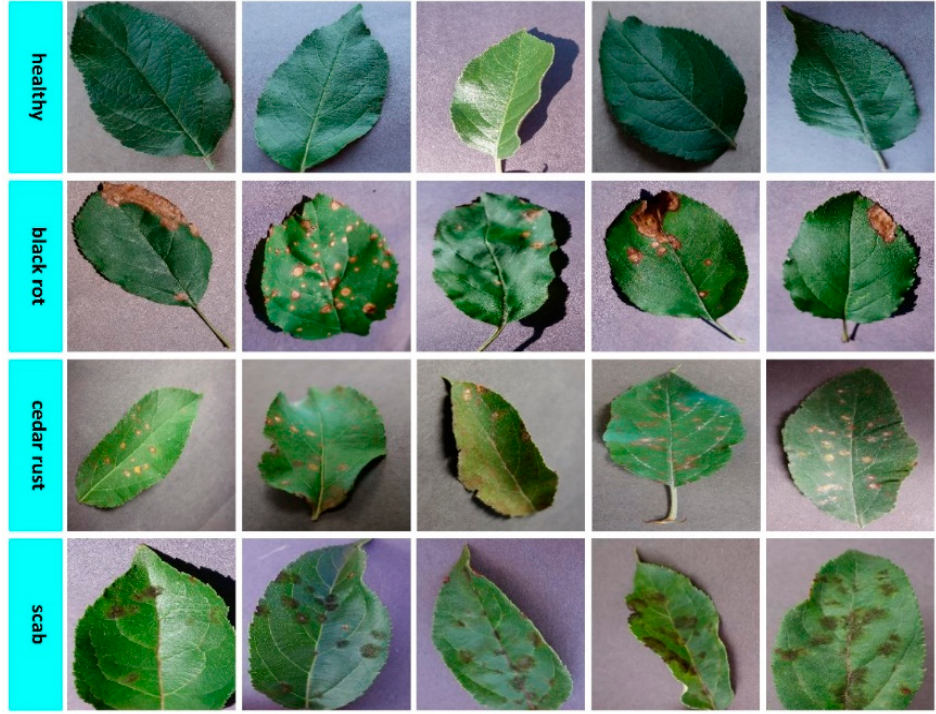
Figure 3. Leaf image examples belonging to healthy and diseased classes of apple plants.